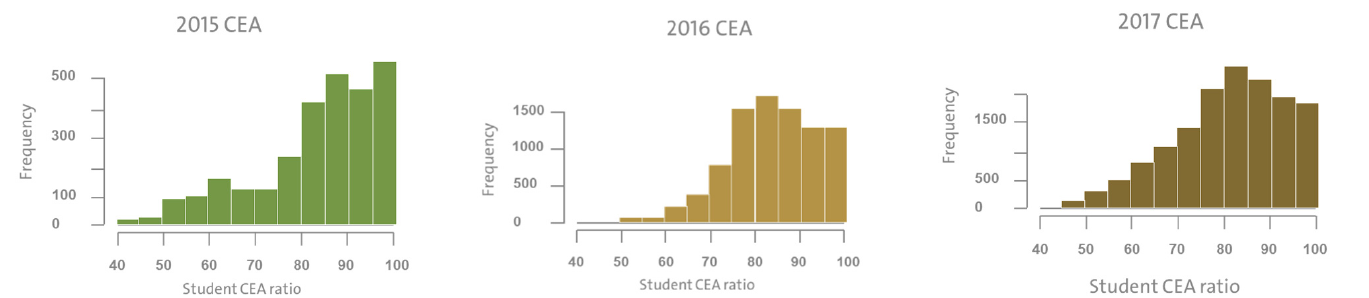
Table 3. The distribution of students admitted to college after the preparatory year.